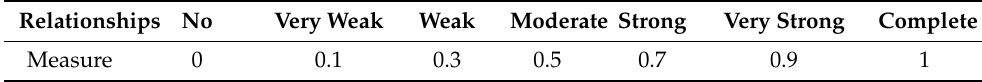
Table 4. Fuzzy measures scale.